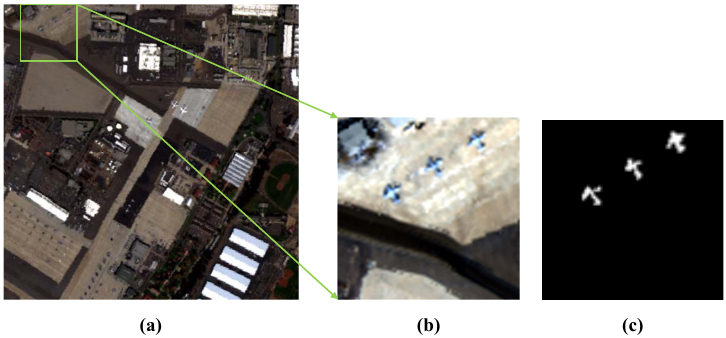
Figure 5. First Real-World Dataset. ( a ) Whole San Diego airport image dataset; ( b ) Upper left of the San Diego airport hyperspectral image; ( c ) Ground truth for the anomaly targets.